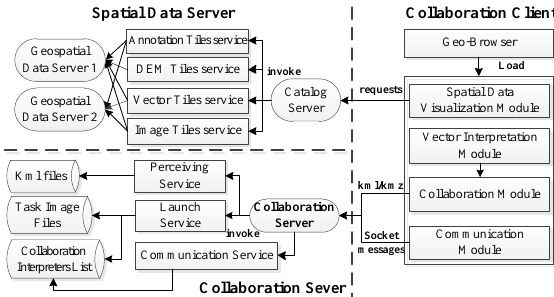
Figure 1. Architecture of collaborative image